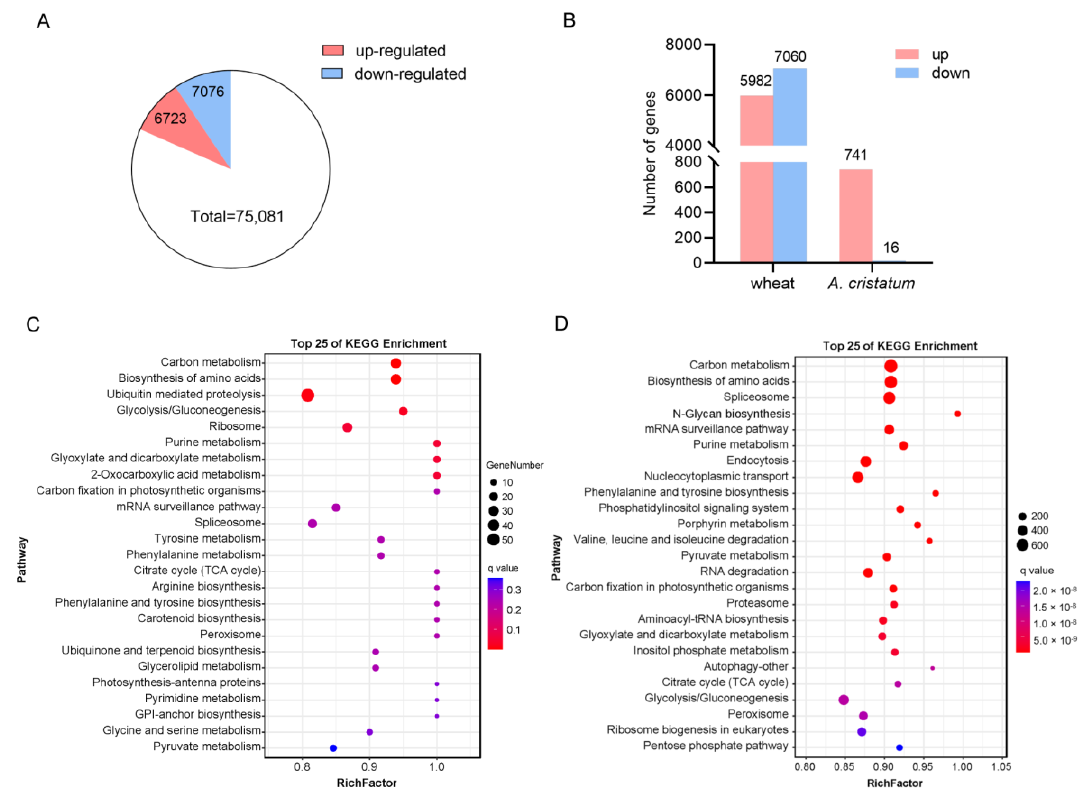
Figure 4. Comparison of DEGs between 5113 and II-30-5. ( A ) Pie chart of DEGs between 5113 and II-30-5. ( B ) Number of DEGs. ( C ) KEGG enrichment of A. cristatum DEGs. ( D ) KEGG enrichment of wheat DEGs.